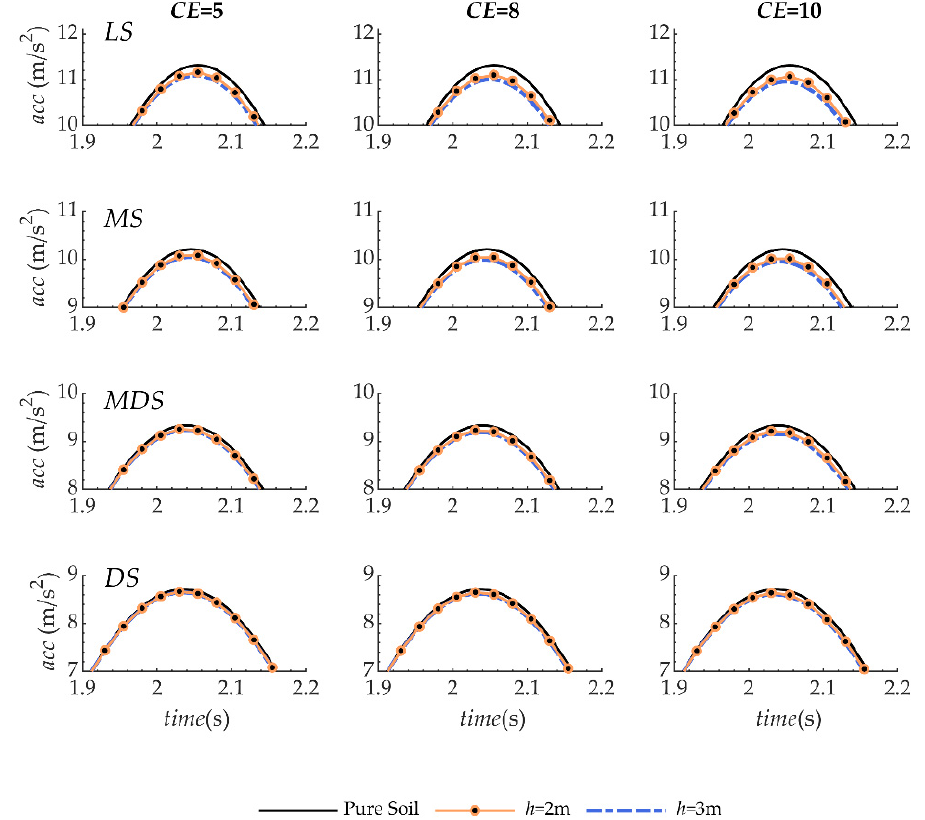
Figure 10. Time-history accelerations recorded on numerical models of pure cohesionless soil at different relative densities and on “modified” cohesionless soil: evidence of the effects of the thickness of the modified layer ( m PUR = 15 kg injected per level).